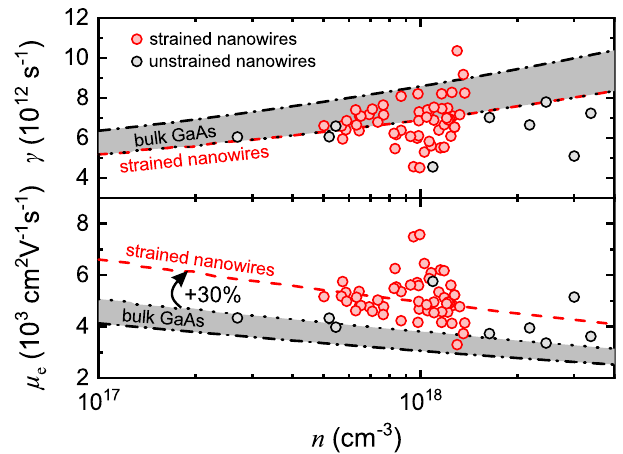
Fig. 6 Momentum scattering rate γ (top) and the associated mobility μ e (bottom) of electrons as a function of electron density n inside the strained core of uncapped GaAs/In 0.37 Al 0.63 As core/shell nanowires (red symbols) and the unstrained core of GaAs/Al 0.35 Ga 0.65 As/GaAs core/shell/capping-shell nanowires (grey symbols). All data originate from optical-pump THz-probe spectroscopy (OPTPS) measurements at room temperature. For comparison, OPTPS data ( fi tted by the Caughey- Thomas relation) for undoped bulk GaAs from refs. 46 (black dotted curve) and 48 (black dash-dotted curve) are also shown. The grey-shaded area covers all values between the two reference curves. The red dashed curves describe the results for strained